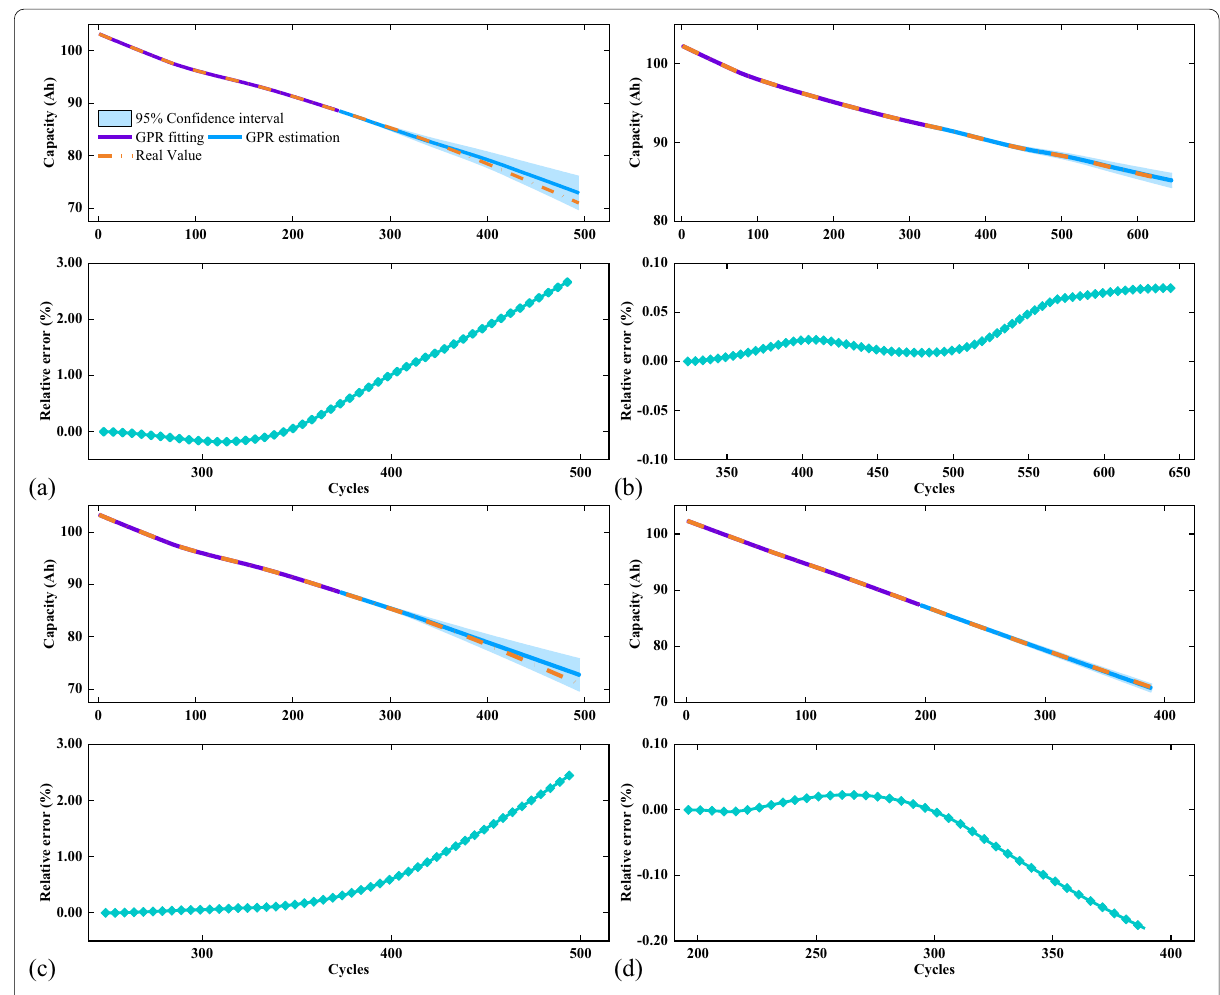
Figure 6 Capacity estimation results for the battery cells in the source domain: a , b Estimation results of the cell with the largest/smallest error using stdQ for HI; c , d Estimation results of the cell with the largest/smallest error using IC peak for